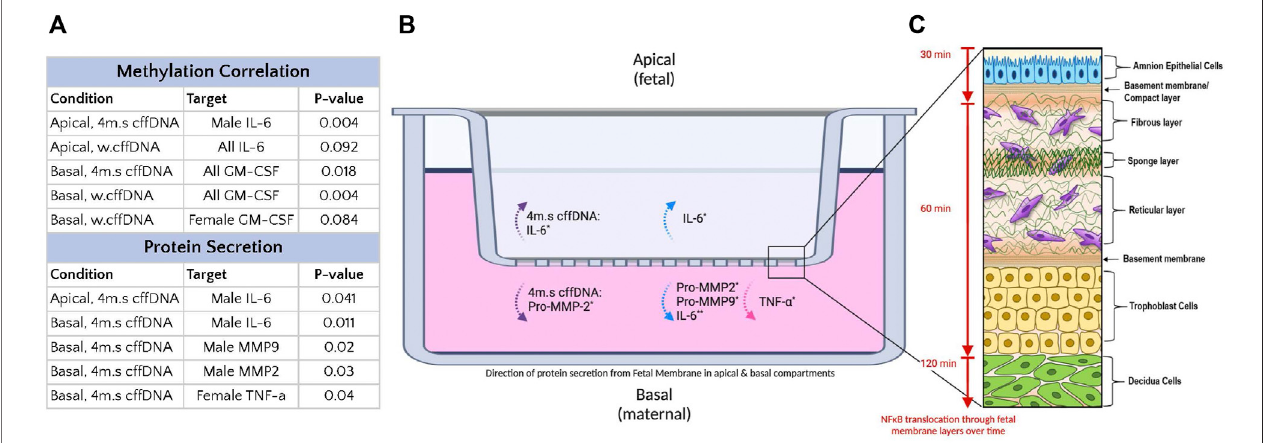
FIGURE 8 | Summary of the effect of fetal DNA on fetal membrane explants from male and female fetus pregnancies. (A) Table of treatment conditions, secretion locations with DNA species causing a response. (B) Transwell system with fetal membrane explant. The secretion into the apical media compartment of IL-6, and pro- MMP-2, into the basal media compartment of IL-6, TNF- α , pro-MMP2, and pro-MMP9. The dotted purple arrow indicates secretion regardless of fetal sex. The dotted blue arrows indicated secretion bymalefetus FM.The dotted pink arrows indicated secretion by female fetus FM. n = 7 – 10patients. * p = < 0.05 ** p = < 0.001. (C) Diagram of fetal membranes (modi fi ed from Richardson et al., 2020) with attached decidua, illustrating the wave of NF- κ B p65 subunit translocation to the nucleus over time (amnion → chorion → decidua) in response to fetal DNA treatment (apical).